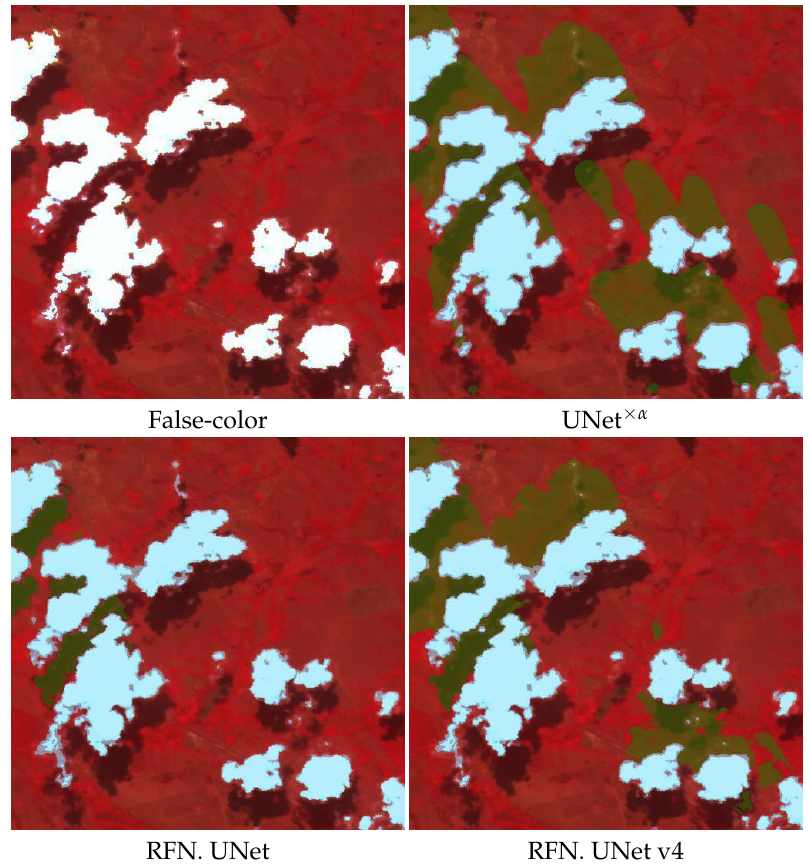
Figure 1. Illustration of a typical segmentation patch. The typical patch is drawn from GF1WFV1.16m.2014267223114.21LTD.FAGUO1.SR.tiff, the false-color image (bands 4, 3, and 2) and the segmentation proposals of which, yielded, respectively, by UNet × α , by our Refined UNet, and by v4, are presented. It can be seen that the edge-refined labels of cloud and shadow regions are generated both by Refined UNet and by v4, in comparison with UNet × α giving region-accurate